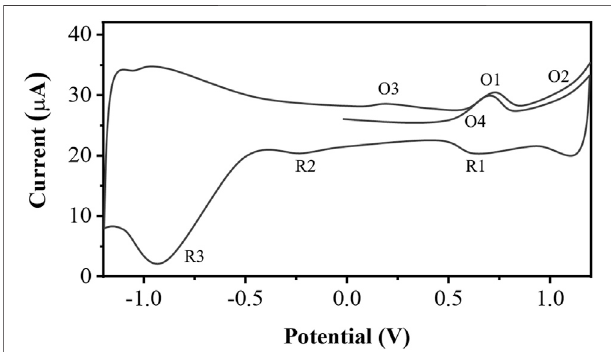
FIGURE 3 | SSEAC spectra of soil